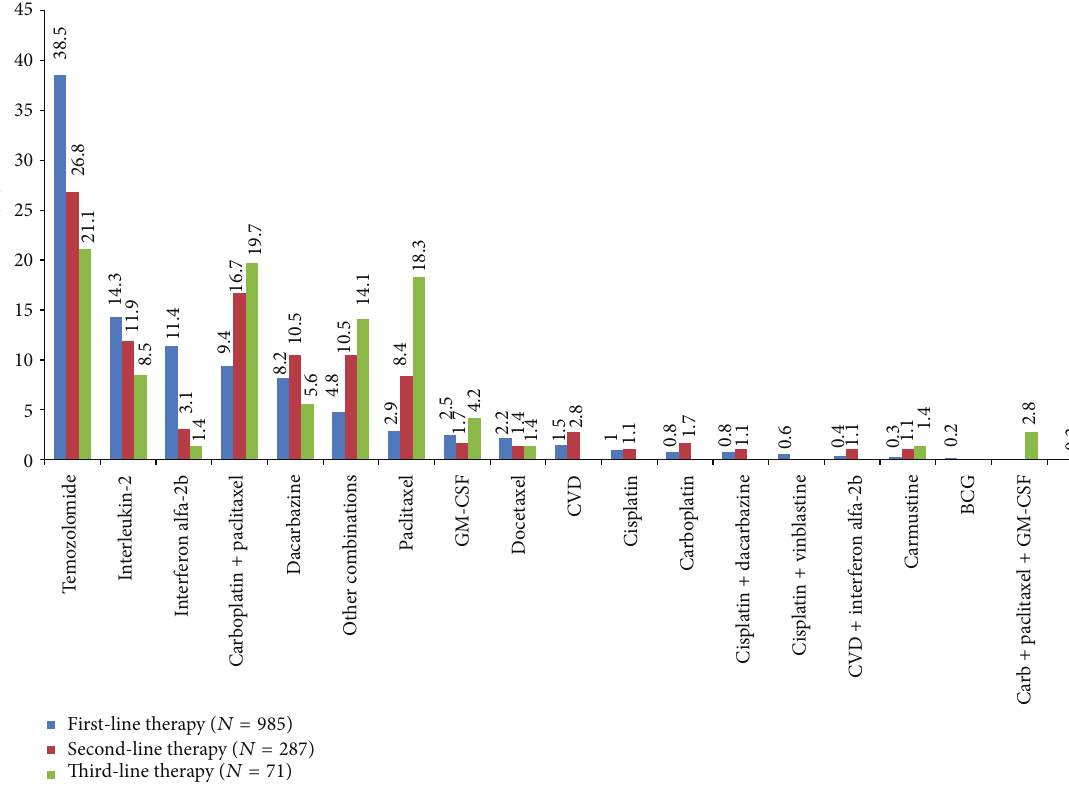
Figure 2: Treatment patterns by line of